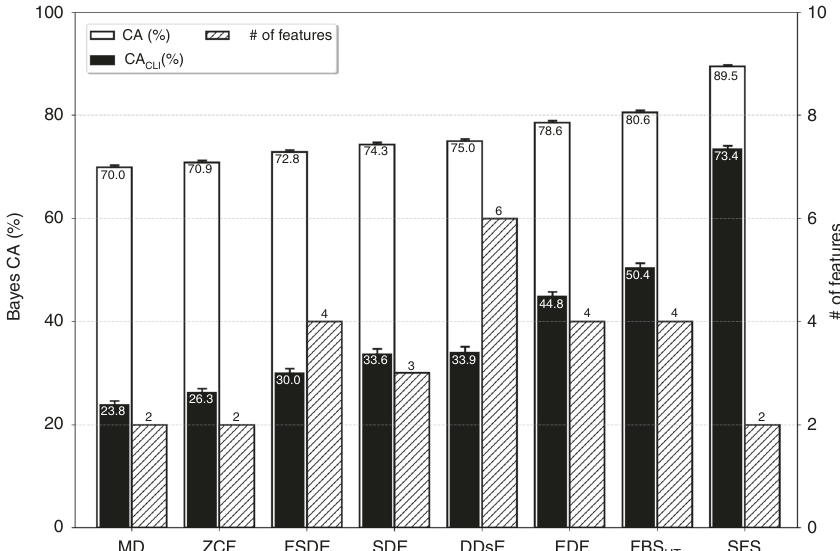
Fig. 6 Number of features, CA, and CA CLI for SFS and previously reported feature extraction/selection methods when followed by a Gaussian Naive Bayes classi fi er for all spike classes ( N = 1472 independent spike classes including 125,120 test wave-shapes; data are presented as mean values ±SEM). The proposed salient feature strategy (with only 2 features) results in signi fi cantly higher classi fi cation accuracy, both with and without chance level removal, compared with other existing feature extraction/selection methods (with four features in the most successful classi fi er 27,28 is used. This classi fi er only requires data statistics